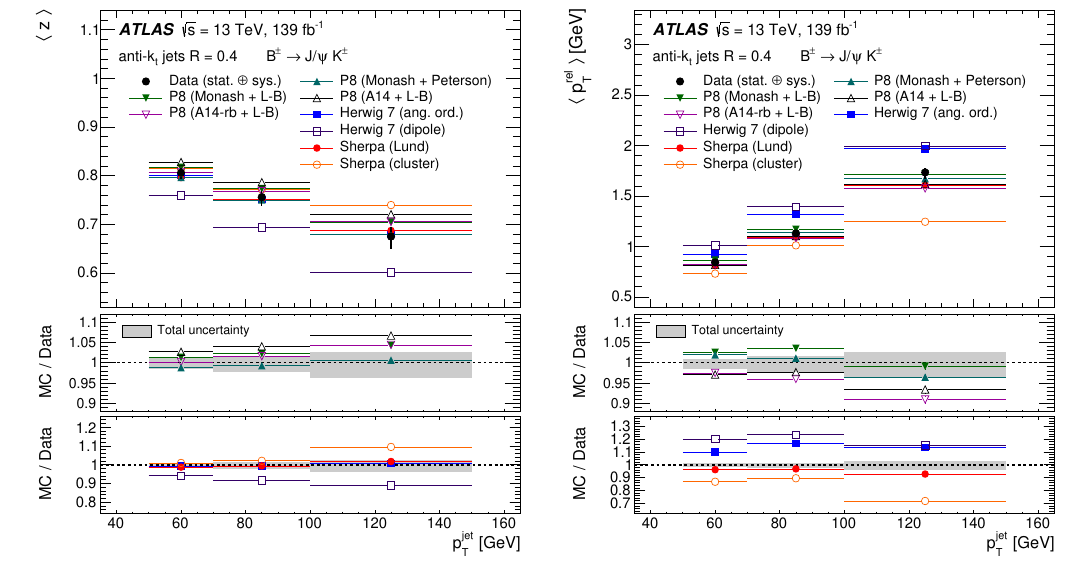
Figure 9 . Average values of the longitudinal profile h z i and of the transverse profile h p rel function of the jet p , compared with MC predictions by Pythia 8, Sherpa and Herwig 7. The T points are in the bin centre. The vertical error bars represent the total experimental uncertainties. The lower panels show the ratios of MC predictions to the data, where the gray bands represent the total